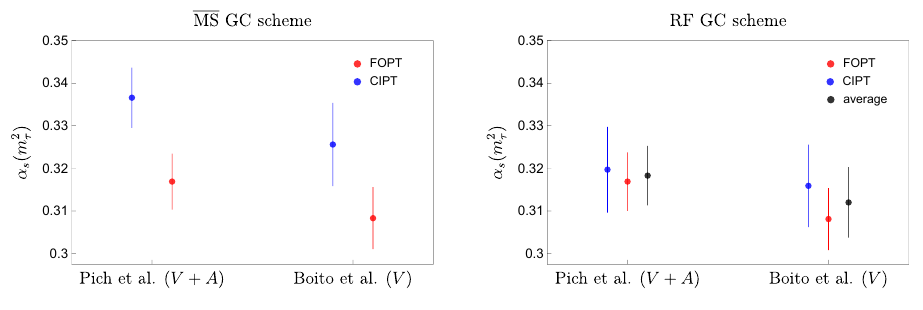
Figure 1. Left panel: Results for α s ( m 2 ) in FOPT (red) and CIPT (blue) in the MS GC scheme, τ following the strategies of Ref. [17] (Pich et al.), based on the tOPE strategy applied to the V + A ALEPH data [19], and Ref. [18] (Boito et al.), based on the DV-model strategy applied to the new vector spectral function of Ref. [18]. Right panel: Results for α s ( m 2 ) in FOPT (red) and CIPT (blue) τ and their average (black) in the RF GC scheme for the same analysis set-ups. The substantial reduction in the CIPT-FOPT discrepancy is clearly